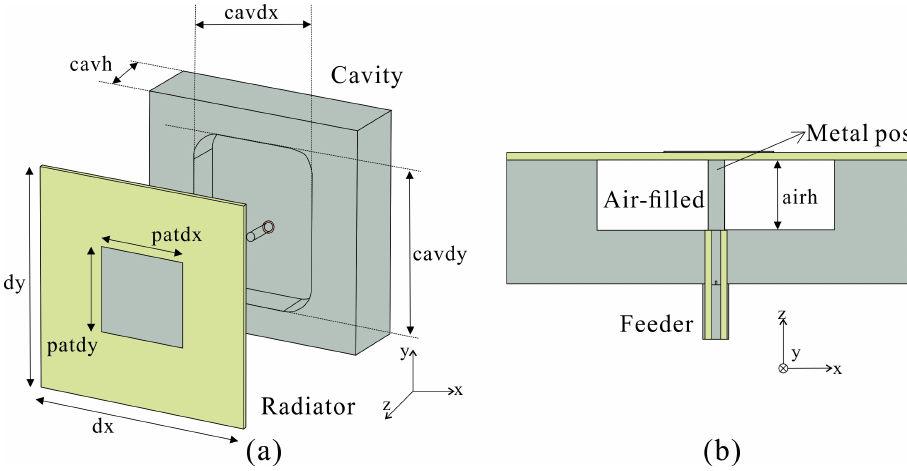
Figure 8. Configuration of the cavity-backed patch antenna: ( a ) overall view, ( b ) side-cut view. Table 2. Design parameters for a cavity-backed patch antenna (unit: